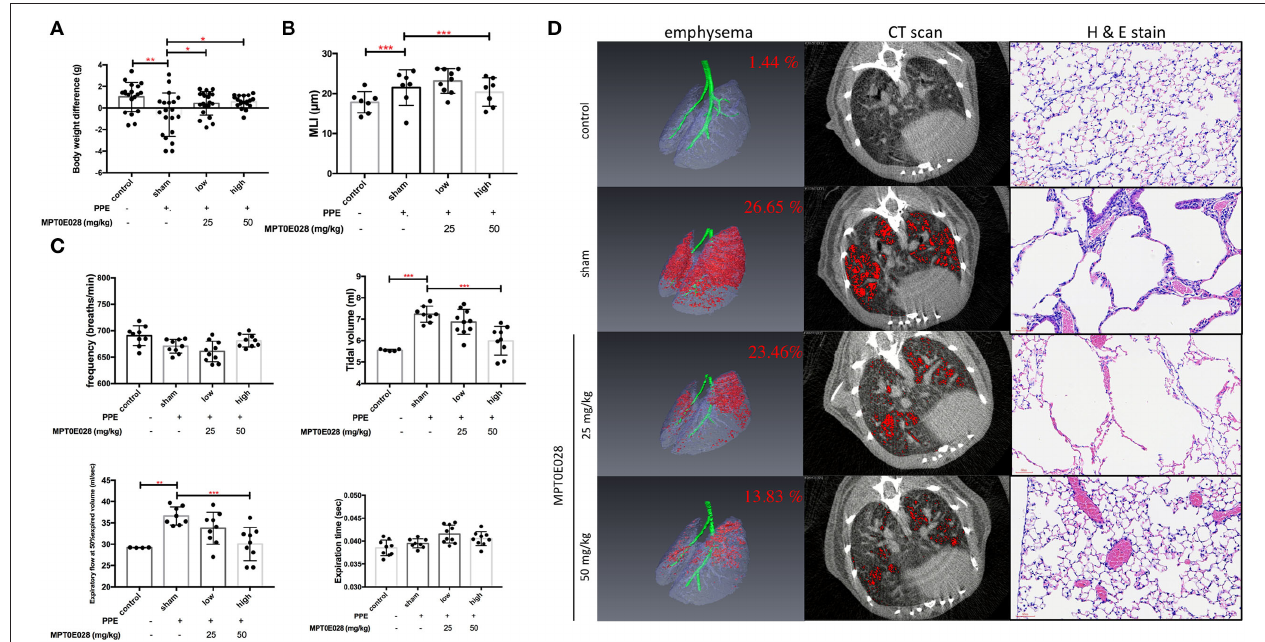
FIGURE 2 | Pulmonary pathophysiology by the MPT0E028 in mice with porcine pancreatic elastase (PPE)-induced emphysema. (A) Body weight (BW) differences after treatment by the MPT0E028 at 0, 25, and 50 mg/kg BW ( n = 20). (B) Emphysema score of the mean linear intercept (MLI) by t the MPT0E028 at 0, 25, and 50 mg/kg BW ( n = 3). (C) Non-invasive pulmonary function test after administration of the MPT0E028 at 0, 25, and 50 mg/kg BW ( n = 10). (D) Emphysema severity by chest CT after treatment with the MPT0E028 at 0, 25, and 50 mg/kg BW ( n = 3). * p < 0.05; ** p < 0.01; *** p <